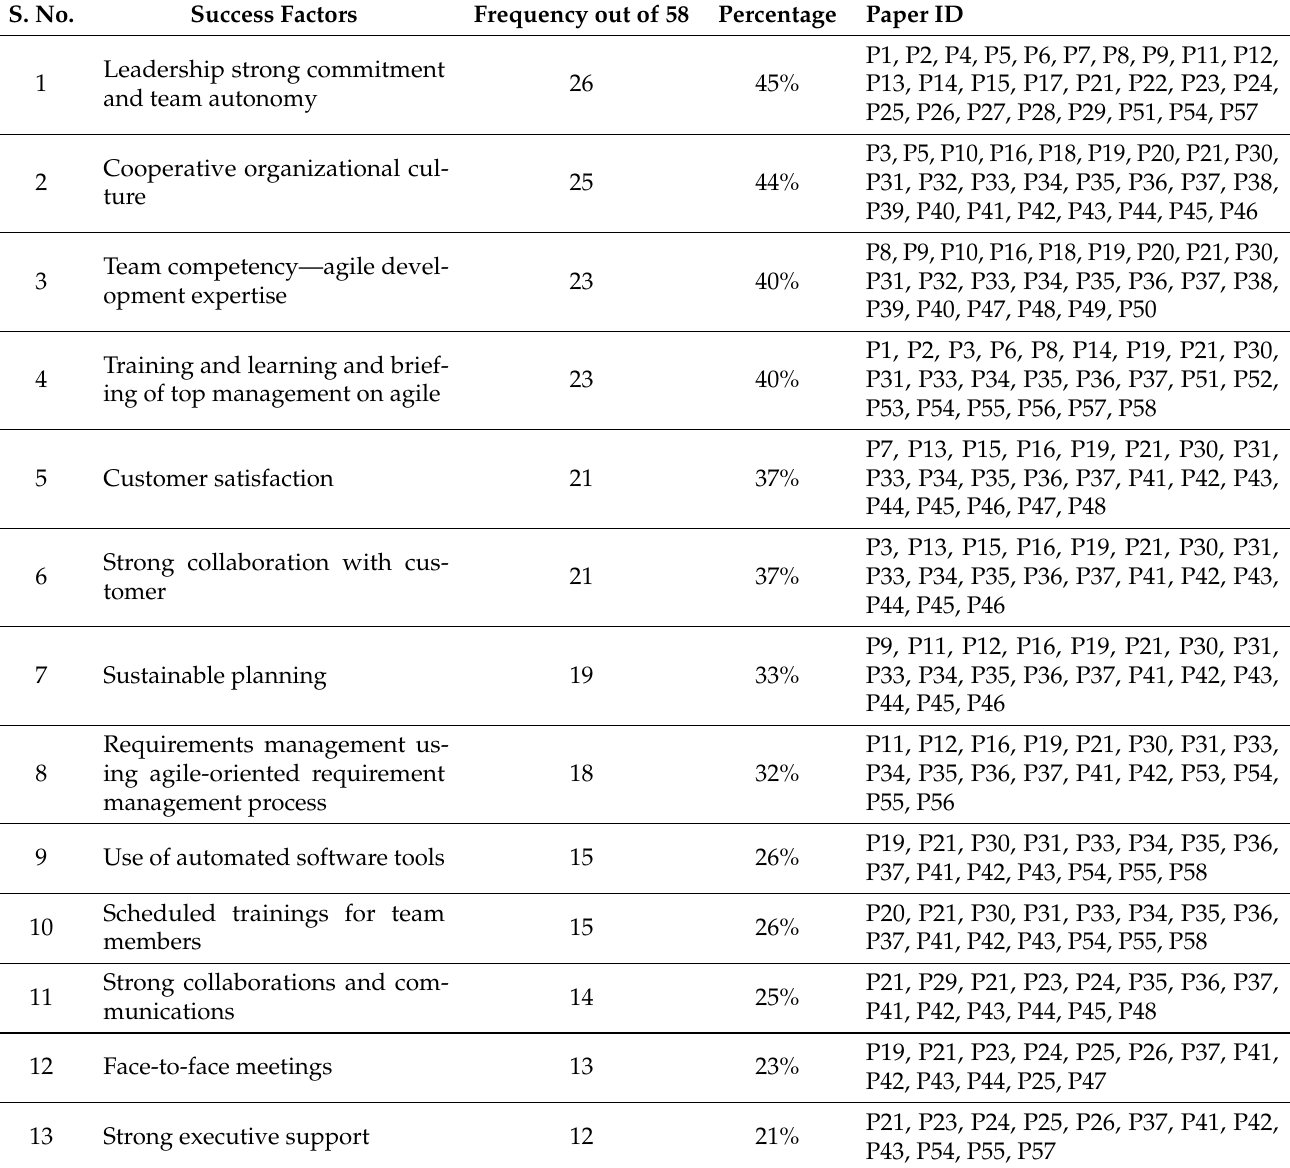
Table 2. Success factors identified via SLR